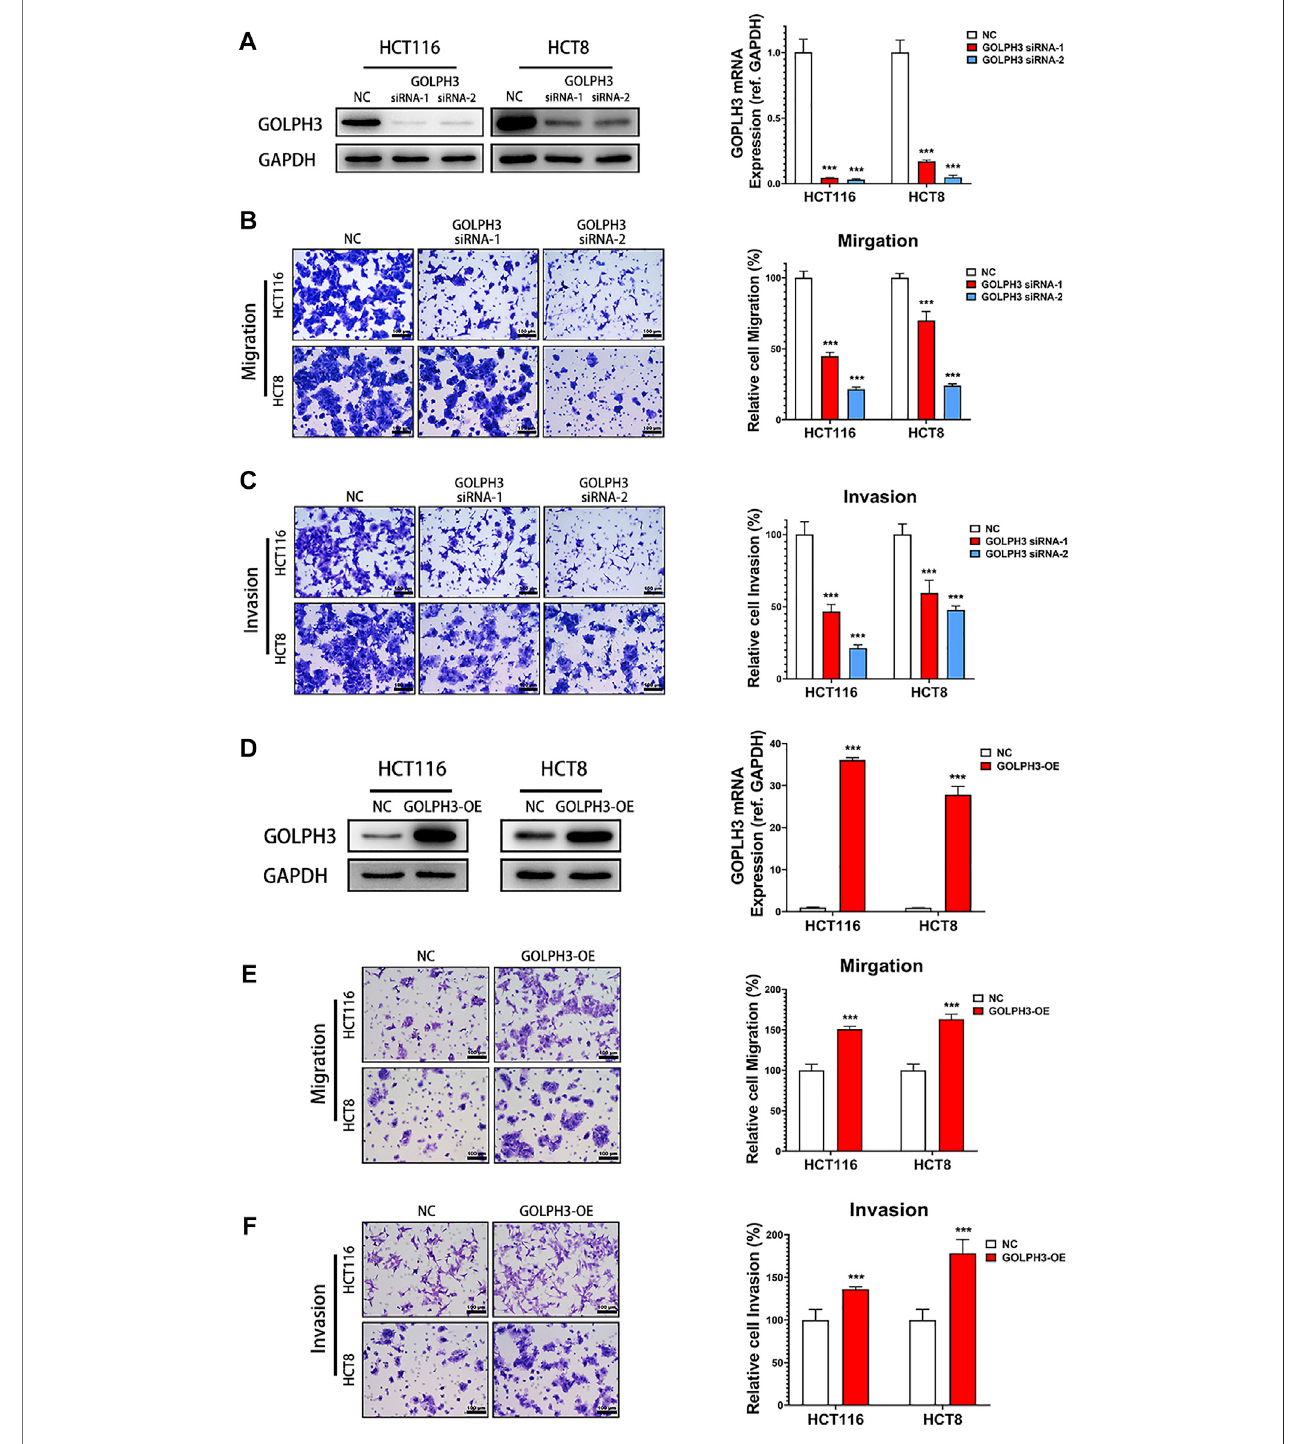
FIGURE 2 | GOLPH3 Knockdown inhibits metastatic phenotypes of colon cancer cells. (A) The knockdown ef fi cacy of GOLPH3 siRNAs in HCT116 and HCT8 cells. TheGOLPH3proteins and mRNA levels ofcontroland siRNA transfected cells weremeasuredby western blotting and qRT-PCR, respectively. (B,C) The effect of GOLPH3 knockdown in HCT116 and HCT8 cells migration or invasion were examined by transwell assay. The number of migratory or invasive cells were counted and normalized to the NC group in fi ve randomly selected fi elds. Representative micrographs are also shown (×200 magni fi cation). (D) The overexpression ef fi cacy of GOLPH3inHCT116 andHCT8 cellsweremeasuredbywesternblottingand qRT-PCR,respectively. (E,F) Theeffect ofGOLPH3overexpressioninHCT116and HCT8 cells migration or invasion were detected by transwell assay. The number of migratory or invasive cells were counted and normalized to the NC group in fi ve randomly selected fi elds. Representative micrographs are also shown (×200 magni fi cation). For (A , D) , results were reproduced in three independent experiments, and representative immunoblots are shown. Scale bar, 100 µm *** p < 0.001.